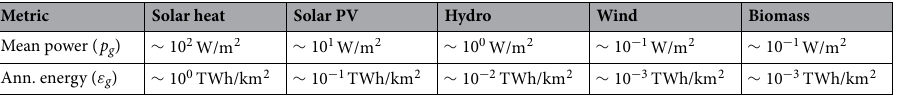
Table 1. Typical order of magnitude of the specific power of renewable flows 1 and recalculated into the annual energy